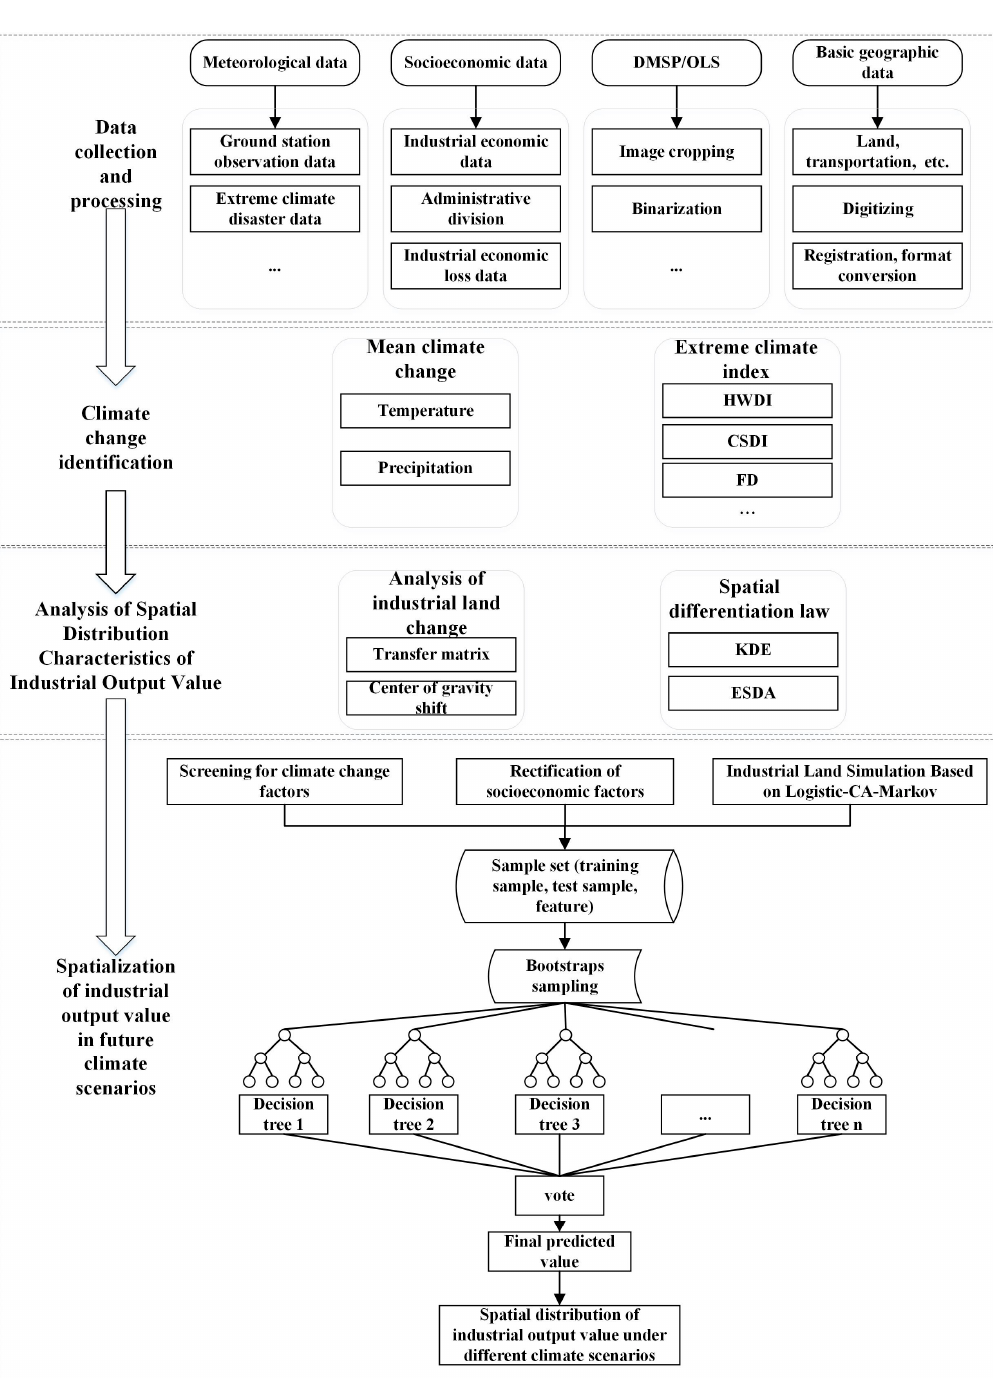
Figure 2. Schematic presentation of the research